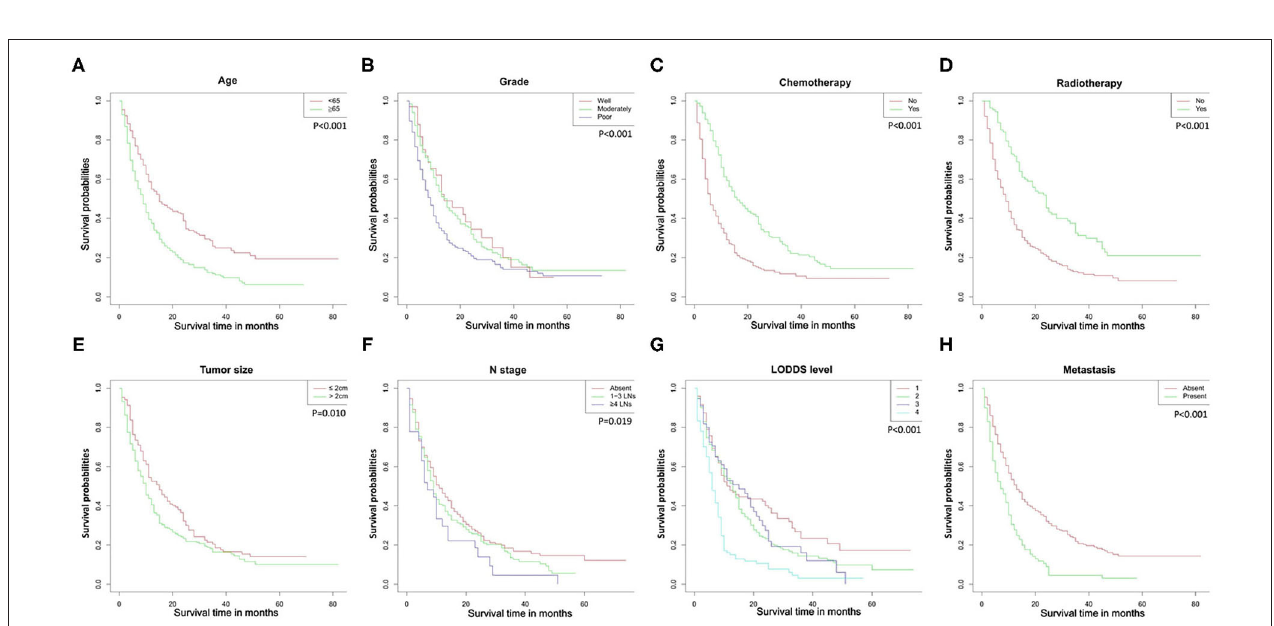
FIGURE 2 | Overall survival rates according to patient characteristics: (A) age; (B) tumor grade; (C) chemotherapy; (D) radiotherapy; (E) tumor size; (F) N stage; (G) LODDS level; (H) metastasis. LODDS, log odds of positive lymph nodes.